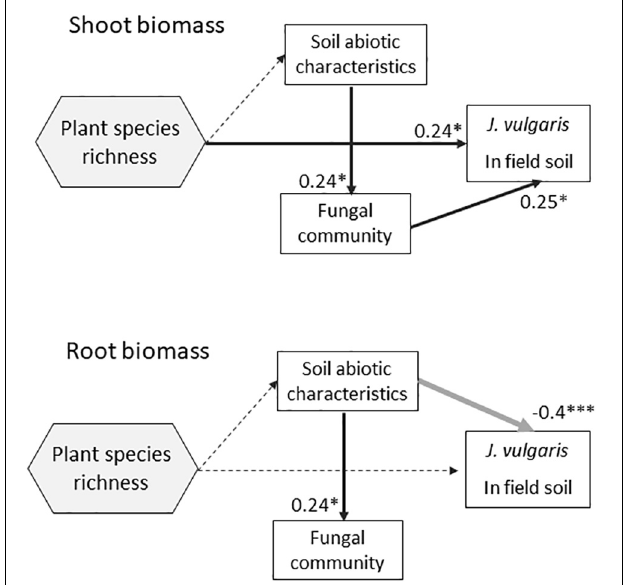
FIGURE 5 | Structural equation model testing the direct and indirect effects (mediated by the changes in soil abiotic characteristics or soil fungal community composition) of plant diversity on J. vulgaris root and shoot biomass in pots with pure field soil. Soil was collected from the field experiment with plots with plant communities that differed in diversity (0, 1, 2, 4, 9 species). Plant species richness was included as fixed continuous factor. For soil abiotic and fungal communities we included the first axis of a multivariate analysis of all soil abiotic characteristics or fungal TRF peaks respectively. The arrows show significant relationships (black = positive, gray = negative), dashed arrows indicate non-significant relationships. The explained variance is also presented and the significance ( ∗ P < 0.05; ∗∗∗ P <